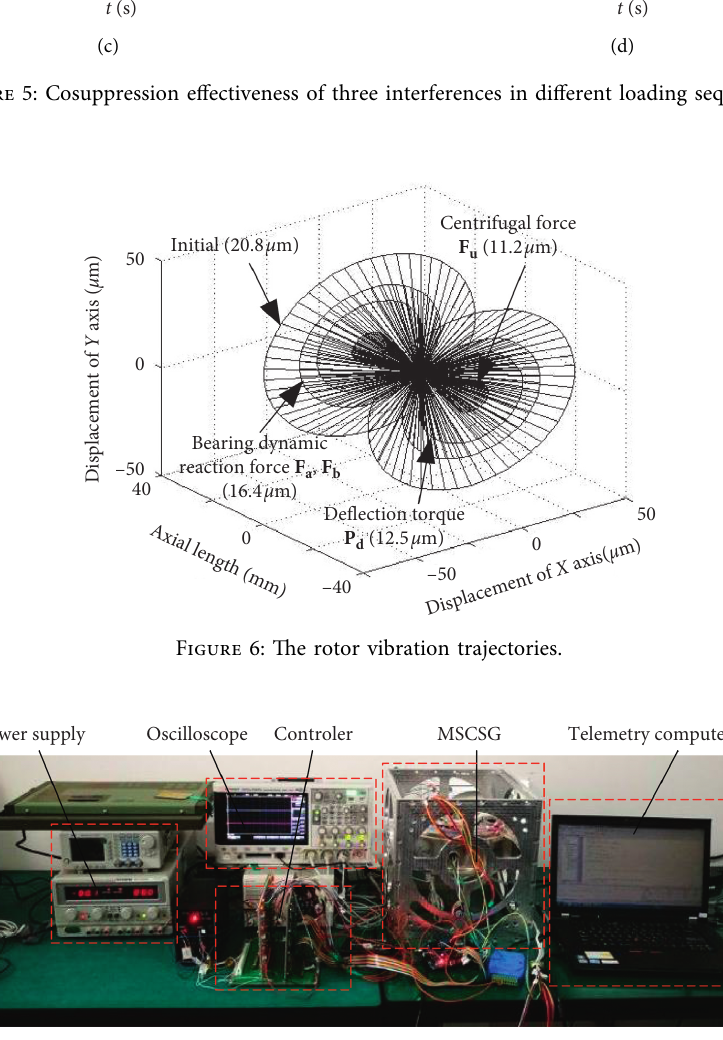
Figure 7: The MSCSG test